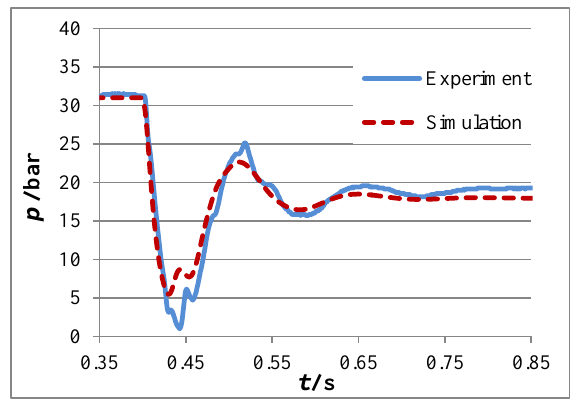
Fig. 8. Time dependencies of measured and simulated pressures .